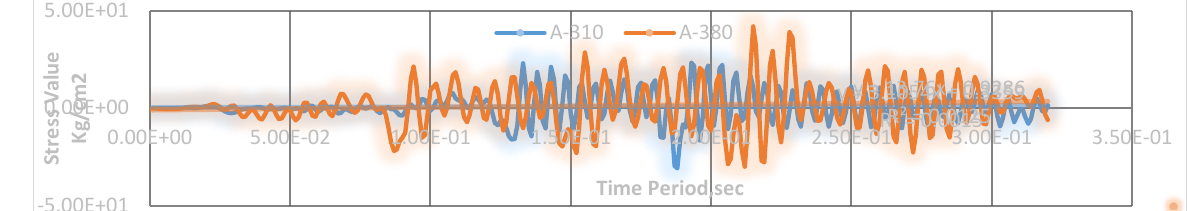
Fig. 10. Stress-Time History Curve for Speed = 160 kmph, h=25cm, E=30000MPa.